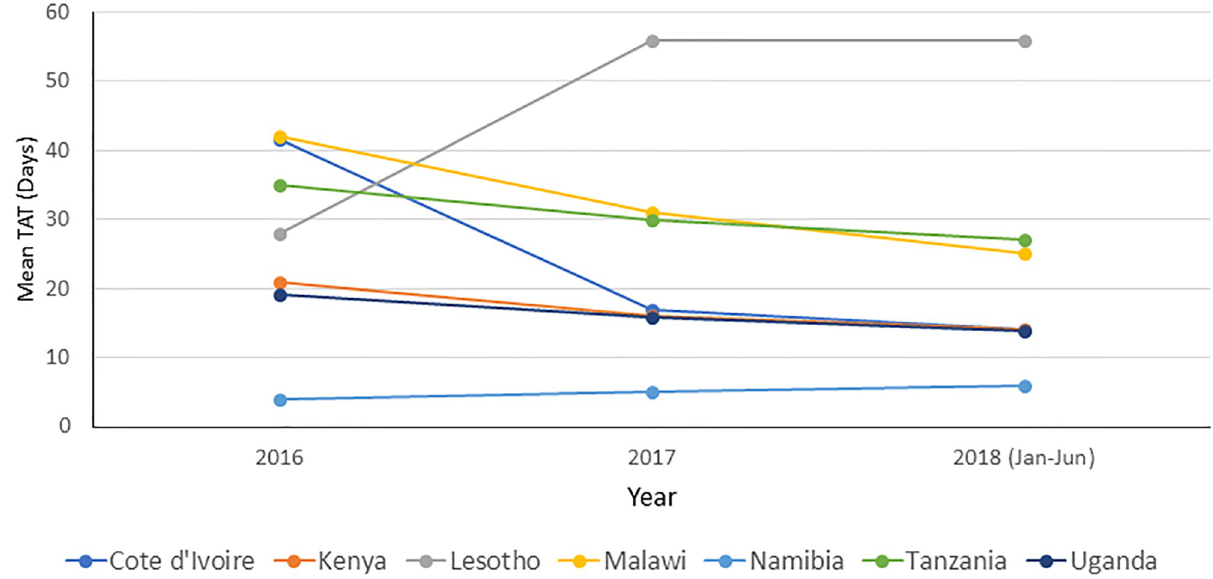
Fig 1. Turnaround time for viral load specimens in seven select countries, 2016–2018. Mean TAT in days (specimen collection to result dispatch) for all VL results returned during the monitoring period.